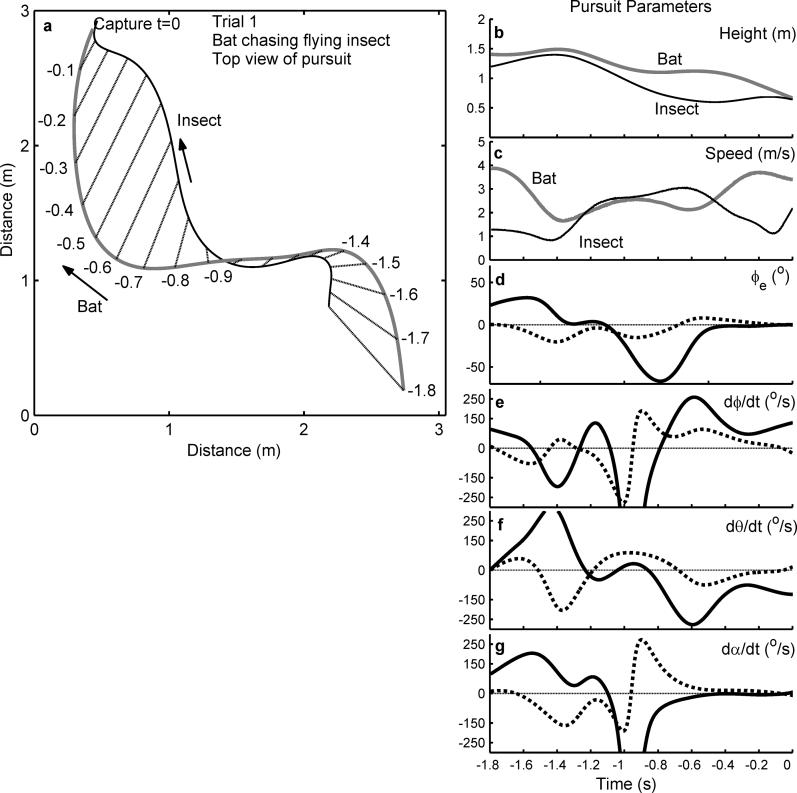
Bat Chasing a Flying Insect(A) Bat (gray line) chases an erratically flying insect (black line) capturing it at time
t = 0. Bearing lines (black dotted) are drawn from the bat to the target every 100ms. Numbers along the flight path indicate the time in seconds to capture.
(B and C) The height (B) and speed (C) of the insect vary continually.(D) The bat maneuvers to drive
φ
e → 0 in the horizontal (solid line) and vertical (dotted line).
(E) The bearing
φ is not held constant as
φ
e → 0 (solid line, horizontal; dotted line, vertical).
(F) The direction of flight (
θ) is not held constant (solid line, horizontal; dotted line, vertical).
(G) As
φ
e → 0, the rate of change of absolute target direction goes to zero (solid line, horizontal; dotted line, vertical). This can also be seen in (A) from the parallel appearance of the dotted lines drawn from the bat to the mantis at 100-ms intervals during the last 700 ms of pursuit (see
Figure 3,
Videos S1–
S4).